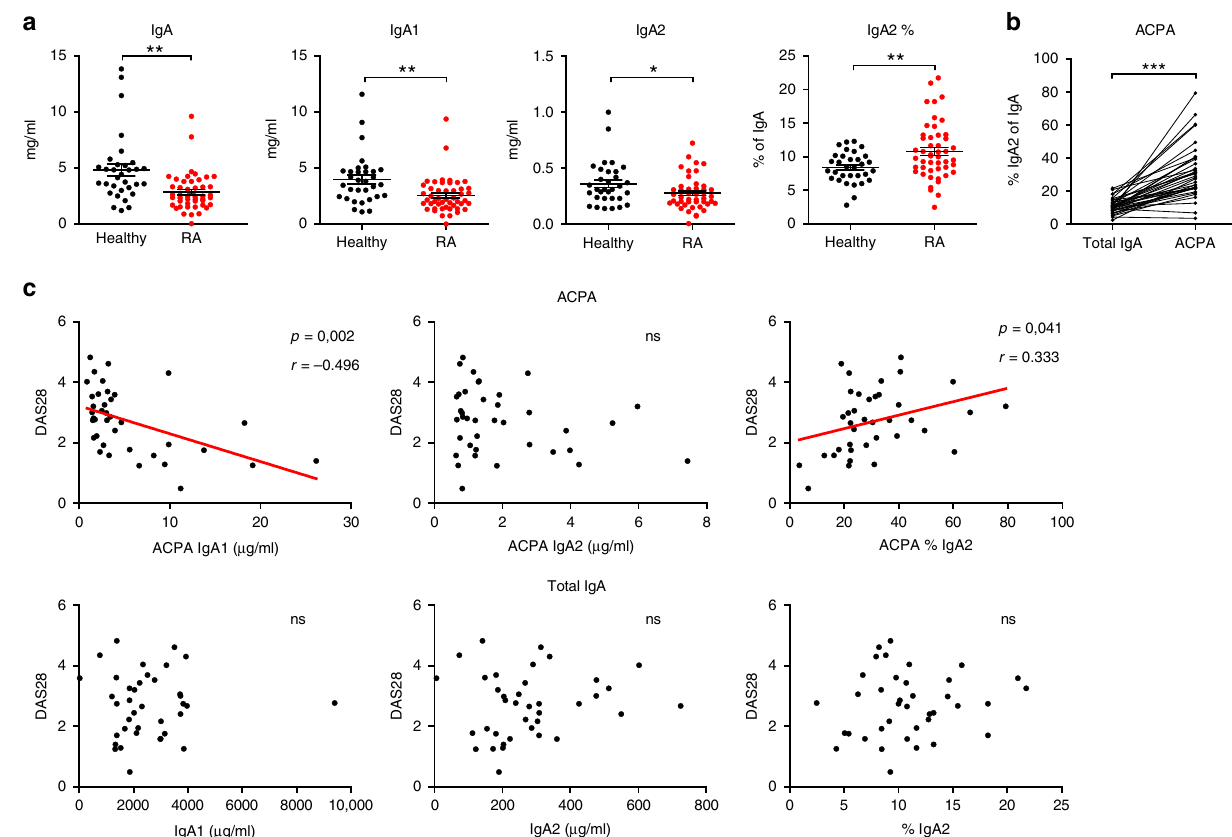
Fig. 5 A high IgA2 percentage in ACPA correlates with higher RA disease activity. a Amount of serum IgA, IgA1, and IgA2 as well as IgA2 percentage in patients with RA ( n = 48) and healthy controls ( n = 32). b IgA2 percentage of total IgA compared to ACPA in the serum of ACPA-positive RA patients ( n = 38). c Correlation of the IgA1 and IgA2 amount, and IgA2 percentage in total serum IgA and IgA-ACPA with the disease activity score (DAS) 28 score of ACPA positive RA patients ( n = 38). Signi fi cances were tested with two-sided Student ’ s t -test using Welch ’ s correction a , paired two-sided Student ’ s t - test b , or Pearson c . * p < 0,05; ** p < 0,01; and *** p < 0,001. Data are presented as scatter plots with mean ± s.e.m. Source data are provided as a Source Data fi